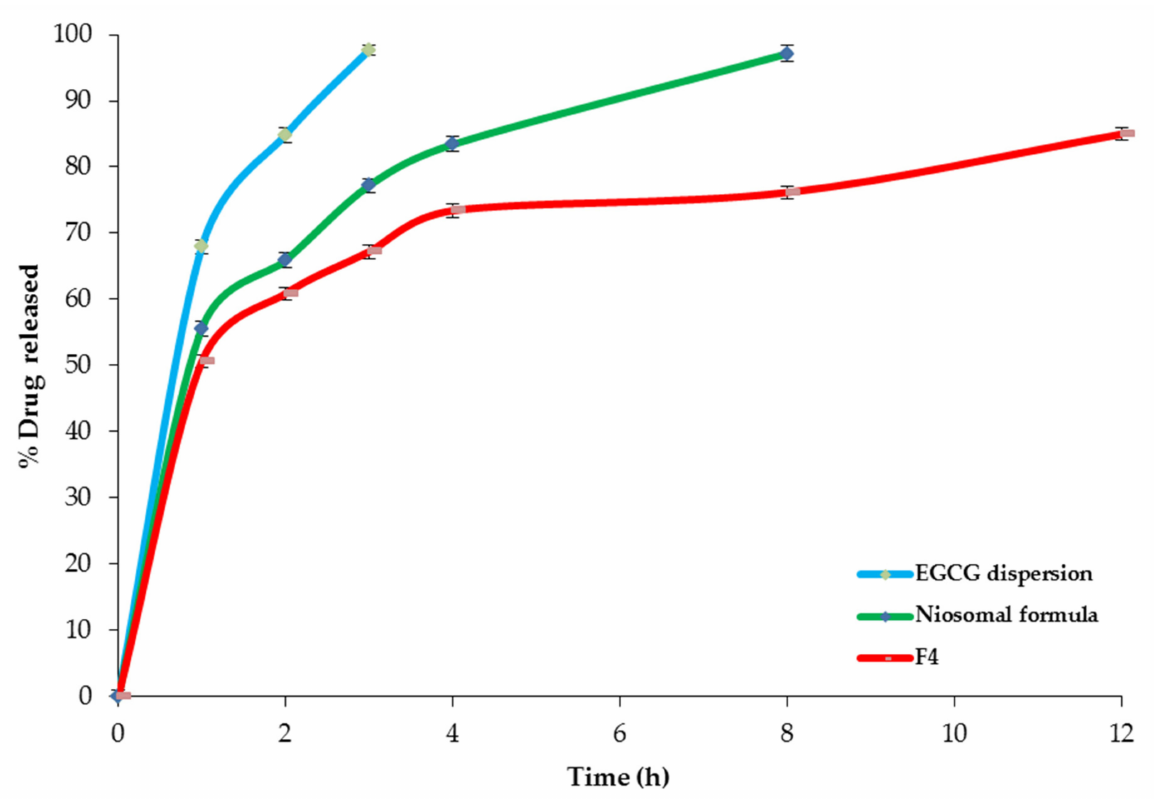
Figure 9. The in vitro release profile of F4, the conventional niosomes, and EGCG dispersion. Abbreviation: EGCG, epigallocatechin gallate.